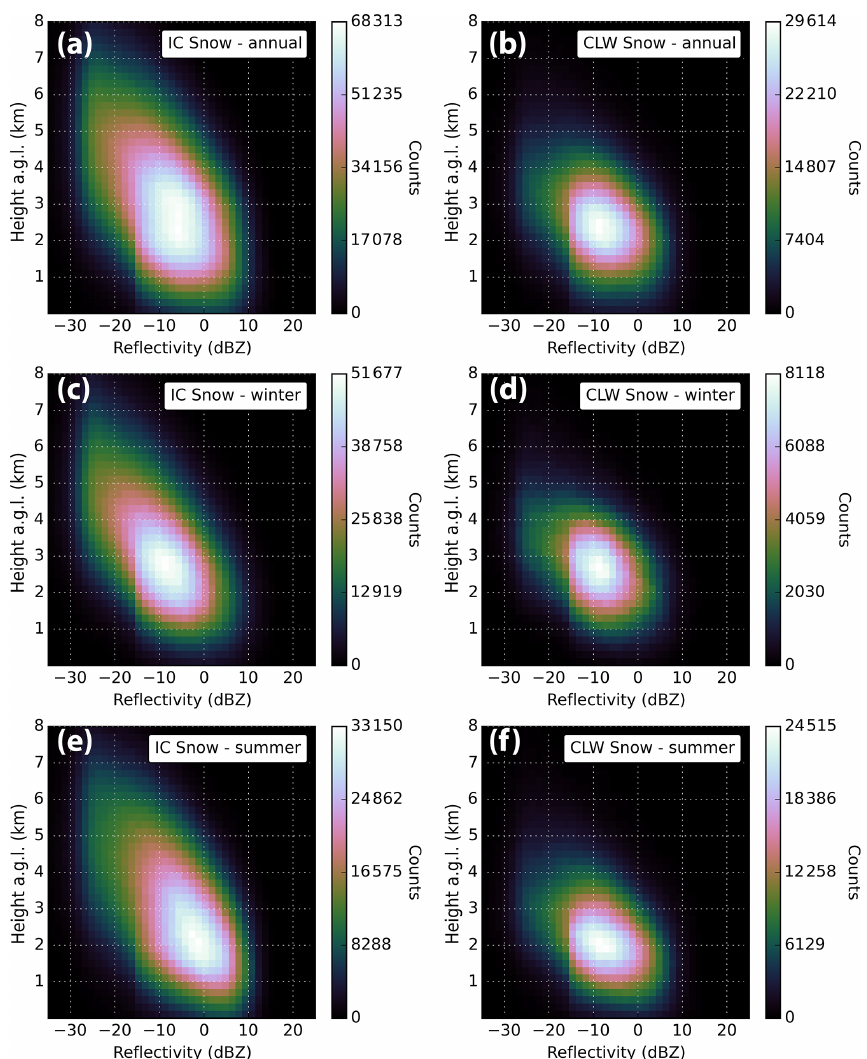
Figure 13. Composite two-dimensional histograms of CPR heights and reflectivities for the two snowfall regimes over the full GrIS. The top row contains the entire annual cycle of events, including every footprint of snowfall detected during the study period, for IC (a) and CLW (b) events. The center row contains all wintertime (October–April) IC (c) and CLW (d) events, and the bottom row contains all summertime (May–September) IC (e) and CLW (f) events. There is a discontinuity apparent in each panel at ∼− 15dBZe. This is due to the 2CSP threshold of − 15dBZe for defining snowfall events. The shape and character of these plots compare well to P18 Fig.